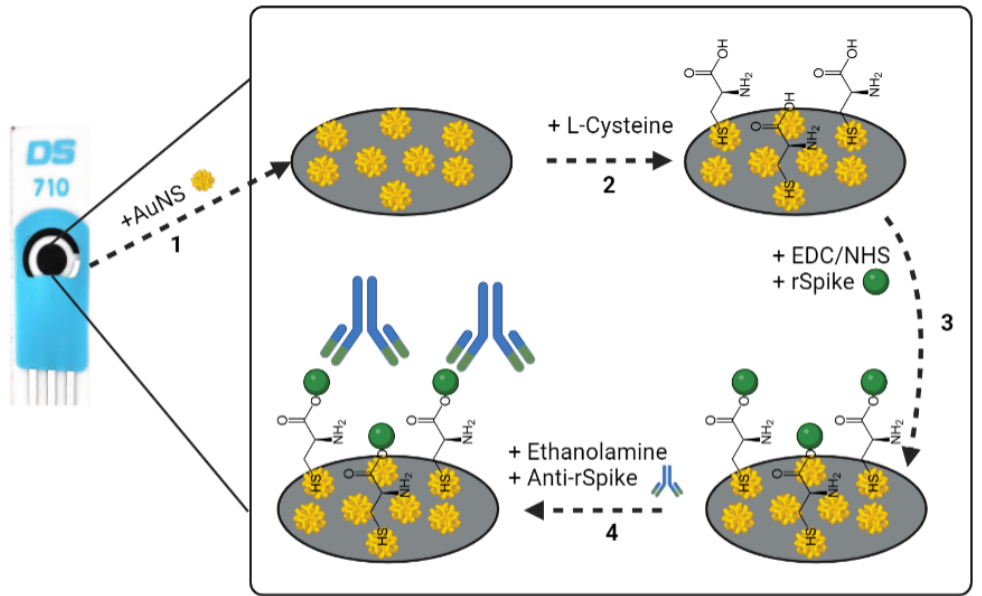
Figure 1. Schematic representation of experimental stages occurring on the SPCE. ( 1 ): The formation of SPCE/AuNS by electrodeposition; ( 2 ): SPCE/AuNS/SAM formation; ( 3 ): the activation of the SPCE/AuNS/SAM by EDC-NHS mixture following SPCE/AuNS/SAM/rSpike formation; ( 4 ): ethanolamine blocking of remaining active functional groups and SPCE/AuNS/SAM/rSpike/anti-rSpike immunocomplex formation via the interaction between immobilized rSpike protein and the anti-rSpike antibodies present in the aliquot.